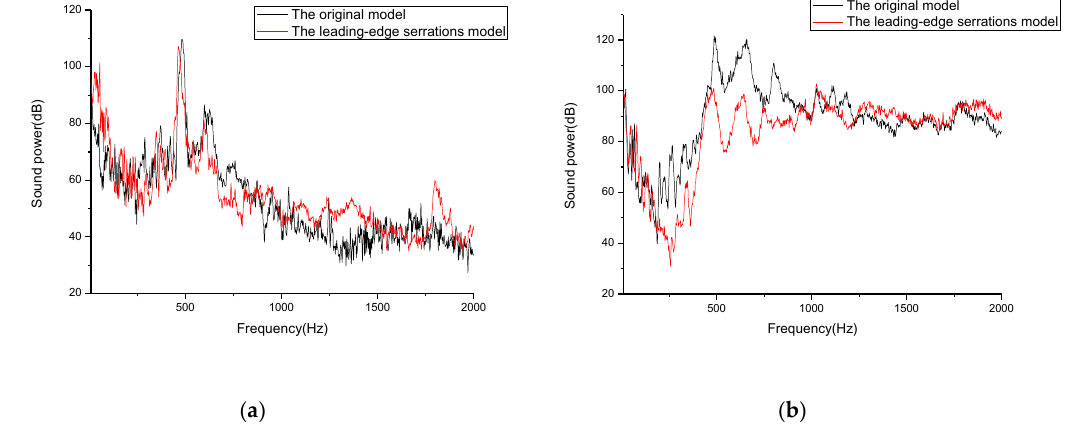
Figure 24. The sound radiation power measured by the vertical hydrophone array in the reverberation tank at different flow velocities. ( a ) 4.62 m/s; ( b ) 8.68 m/s. If the frequency is less than 1000 Hz, the sound radiation power from the model with leading-edge serrations is less than that in the original model. When the frequency is higher than 1000 Hz, the sound radiation power from the model with leading-edge serrations is bigger than the original model. Therefore, the trend of sound radiation power changing with the frequency in Figure 245b is similar to that in Figure 1920.